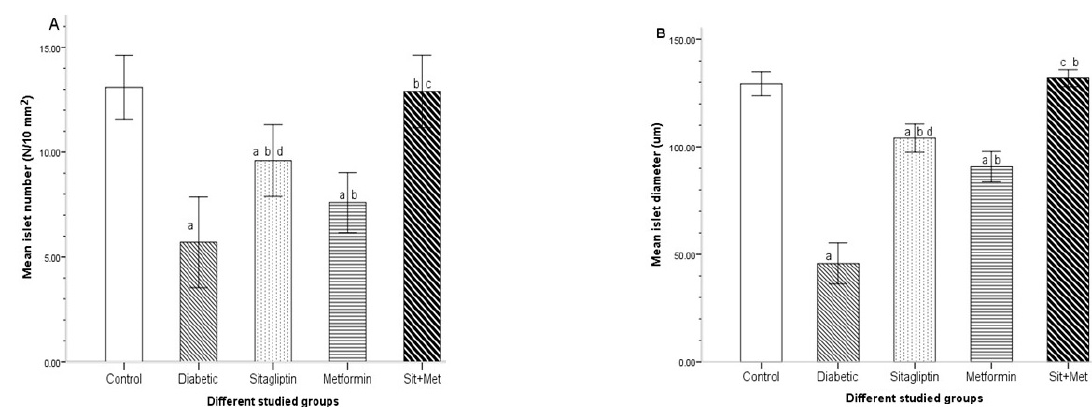
Figure 8. The pancreatic islet number ( A ) and islet size ( B ) in the di ff erent studied groups, at the end of the study period. The data were expressed as mean ± SD (n = 10). a : significantly di ff erent when compared to control, b : significantly di ff erent when compared to diabetic, c : significantly di ff erent when compared to sitagliptin and metformin, d : compared to metformin, using post hoc ANOVA (LSD), p < 0.05.